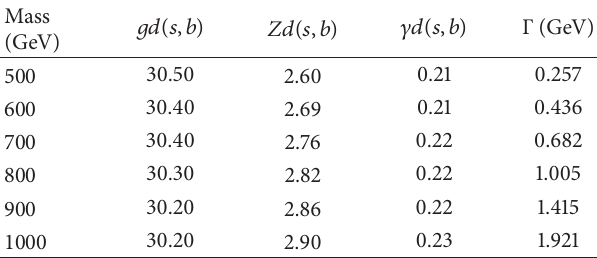
Table 3: Branching ratios (%) and decay width of the new heavy quark ( 𝑏 󸀠 ) with only anomalous interactions for PI parametrization and 𝜅/Λ = 0.1 TeV −1 .